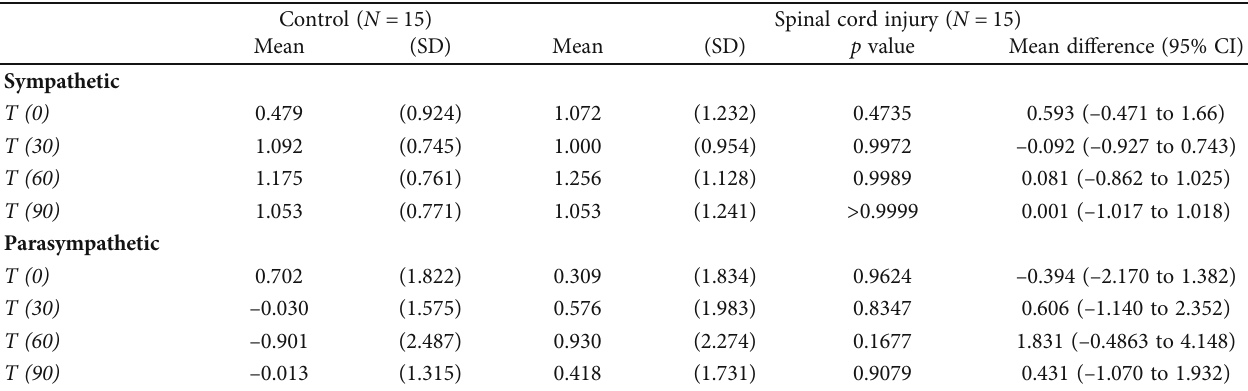
Figure 2: Postural analysis of the average plantar pressure of the evaluated individuals during the intervention period with the exoskeleton. (a) Image of the distribution of the average plantar pressure in the 50 s evaluation interval. (b) Average plantar pressure values every 30minutes of wearing the exoskeleton in control and spinal cord groups. Table 3: Functional analysis of the autonomic nervous